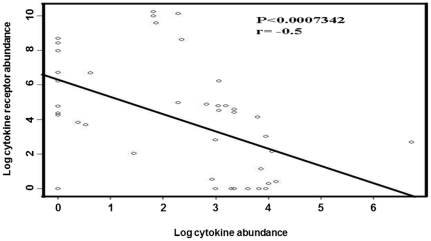
The correlation between cytokines/chemokines and their receptors.Figure 6 shows a significant negative correlation between cytokines/chemokines and their receptor genes. Illumina results were derived from two independent experiments. Each experiment was done in duplicate.